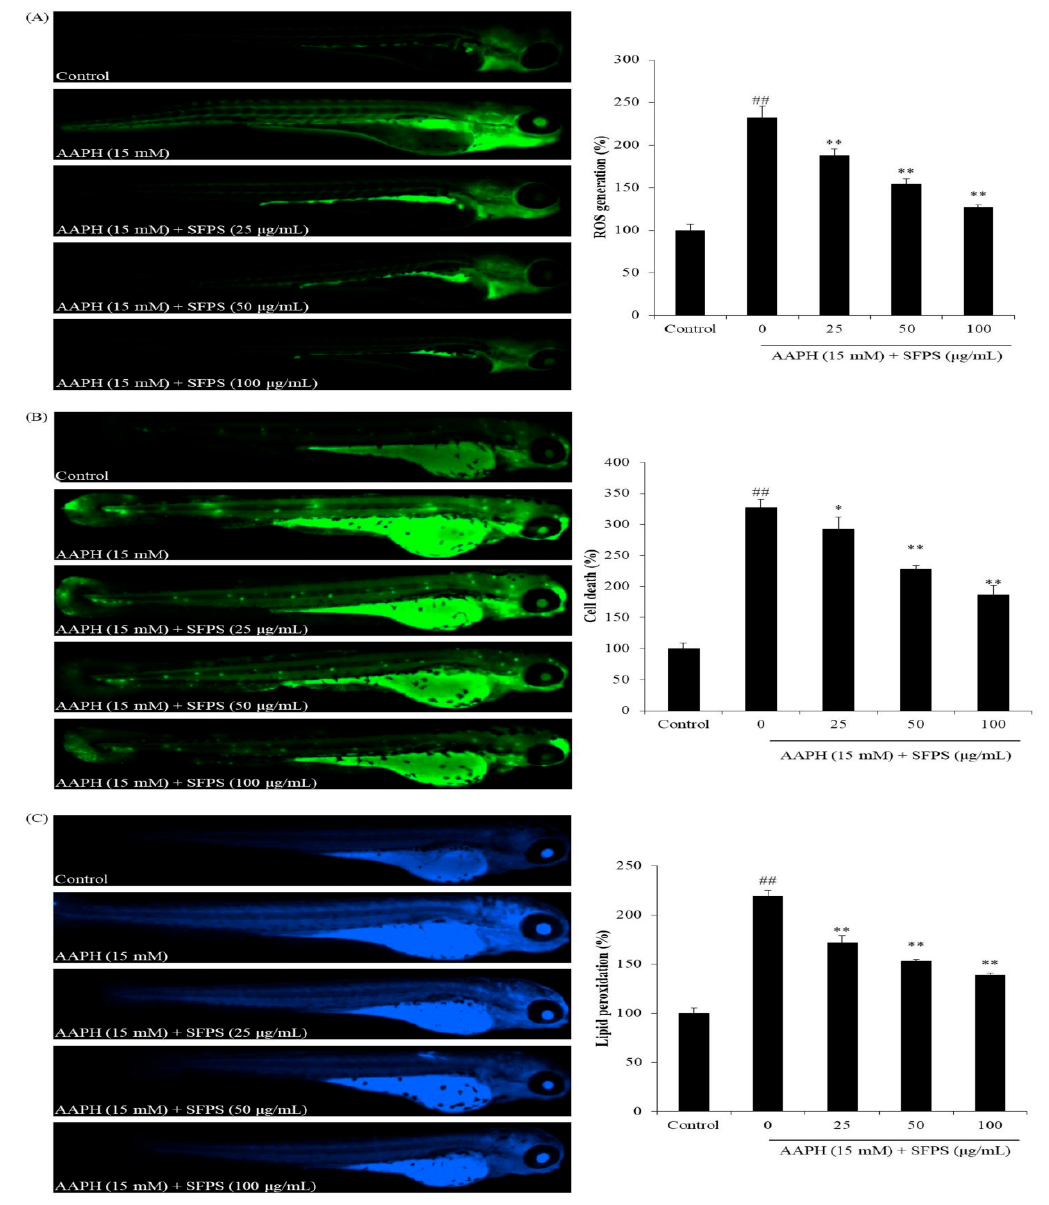
Figure 5. The protective effects of SFPS on AAPH-stimulated oxidative stress in zebrafish. ( A ) ROS generation; ( B ) cell death; and ( C ) lipid peroxidation. ROS, cell death, and lipid peroxidation levels were measured by Image J software. The data are expressed as means ± SE ( n = 3). * p < 0.05, ** p < 0.01 as compared to the AAPH-treated group and ## p < 0.01 as compared to the control group.